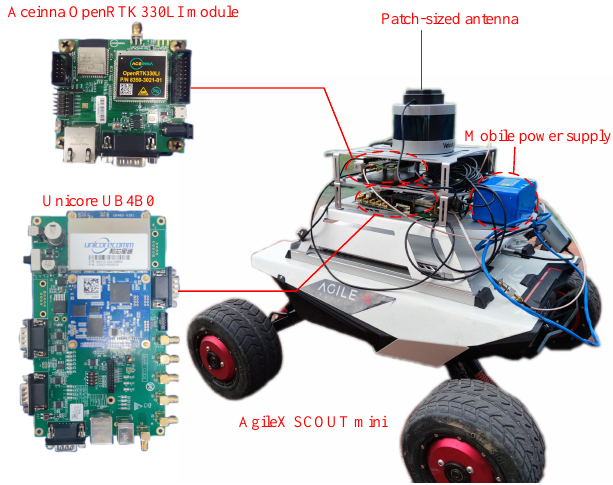
Figure 2: The hardware platform of our experiments.